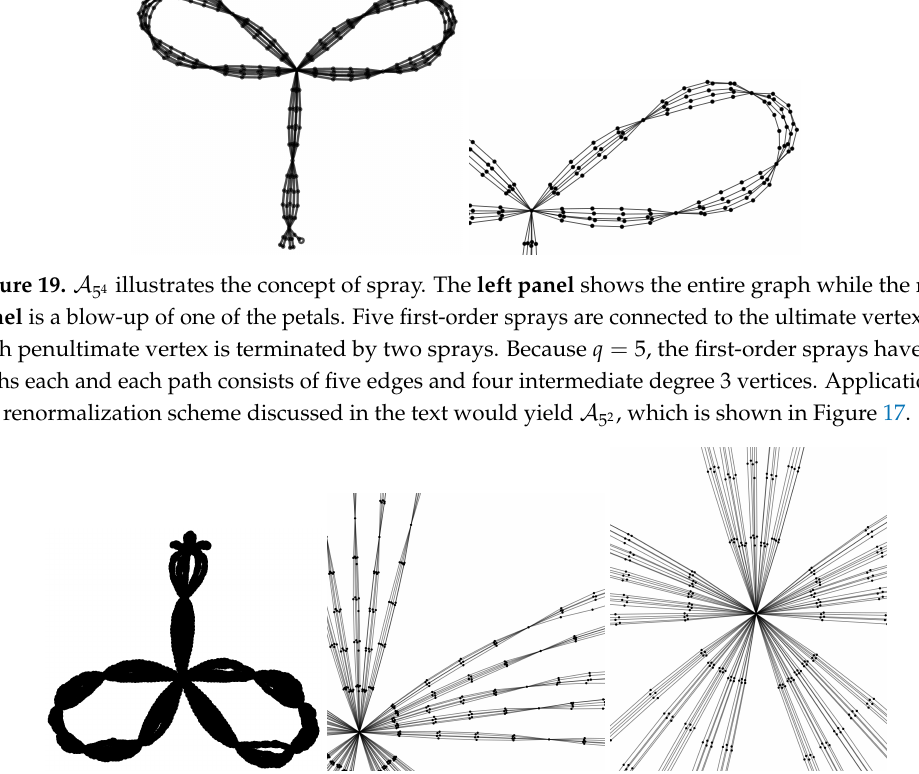
Figure 20. A 5 6 is an example of a graph with second-order sprays. The left panel shows the entire graph while the middle and right panels are blow-ups of the area around the ultimate vertex. Five second-order sprays are connected to the ultimate vertex and each member of the spray is itself a (first-order) spray. Twenty-five first-order sprays connect the ultimate vertex to an antepenultimate vertex. These 25 first-order sprays are organized into five second-order sprays, each of which connects the ultimate vertex to the the penultimate vertex. Because q = 5, the first-order sprays have five paths each and each path consists of five edges and four intermediate degree 3 vertices while the second-order sprays have five paths of first-order sprays. One iteration of the renormalization scheme discussed in the text would yield A 5 4 which is shown in Figure 19. A second iteration of the renormalization scheme would yield A 5 2 , which is shown in Figure